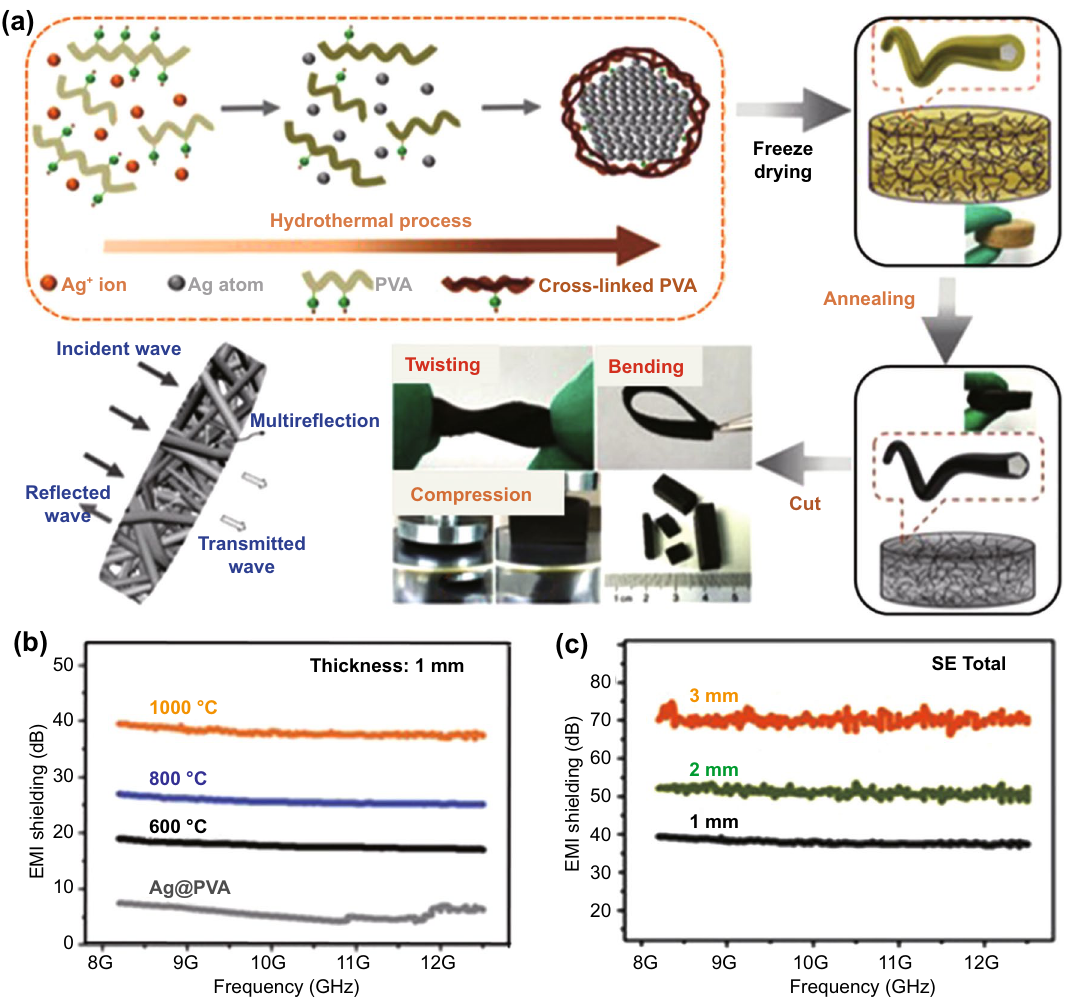
Fig. 10 a Schematic illustration of fabrication of silver wire wrapped carbon core–shell (Ag@C) hybrid sponge and its application in EMI shielding. b, c EMI shielding performance of Ag@C-1000 sponge with different thicknesses and SE T [120]. Copyright © 2018 WILEY ‐ VCH Verlag GmbH & Co. KGaA,